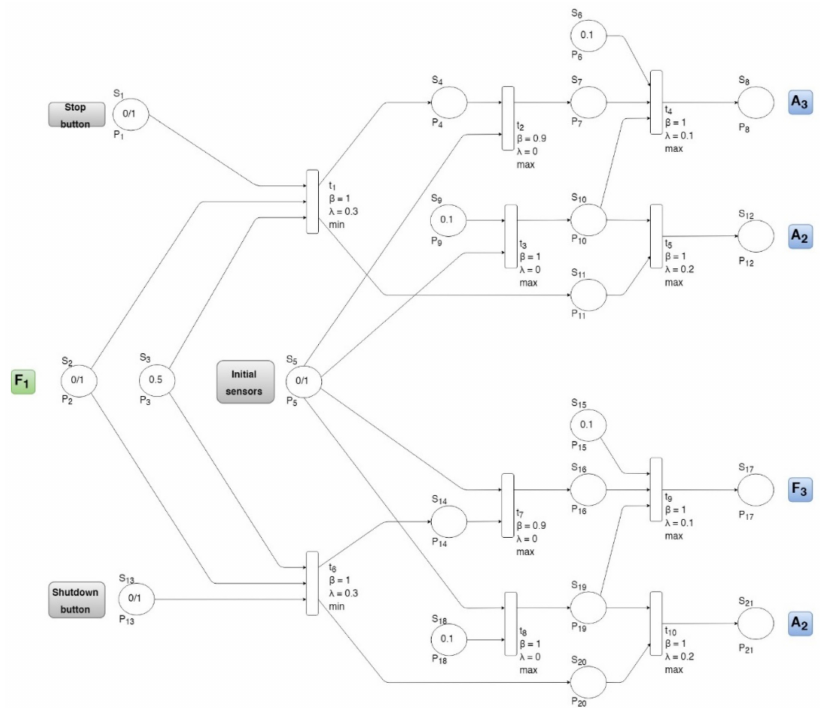
Figure 7. A graphical structure of the fuzzy Petri net algorithm for the transition between the normal production mode (F1) and the different stop modes of the